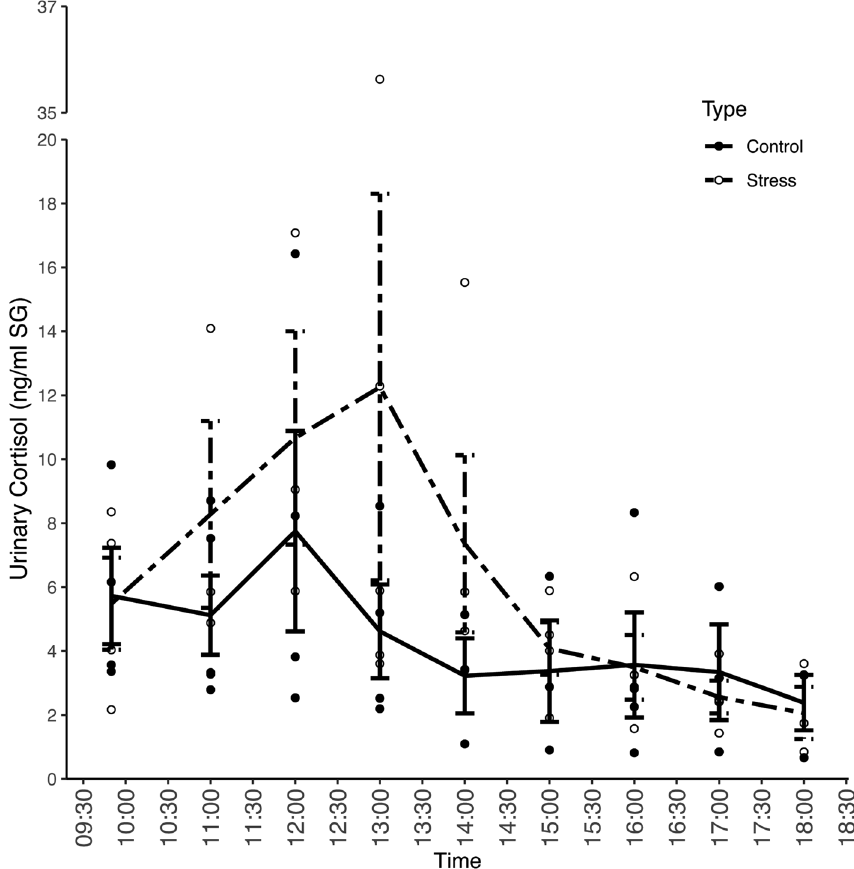
Figure 1. Mean (+ SEM) urinary (N = 108) cortisol levels in bonobos during the control day (solid line) and stress day (dashed line). The local veterinarian (the stressor) entered the building at 10:18 h. The analyses were conducted on log transformed cortisol data but actual values are displayed here to provide better visual and interpretable representation of the cortisol response.